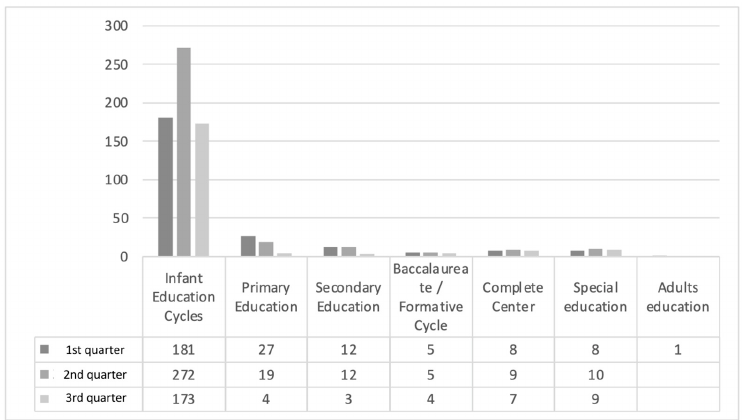
Figure 3. Classrooms closed during the school year by training cycle*. Source: Own elaboration. * p =